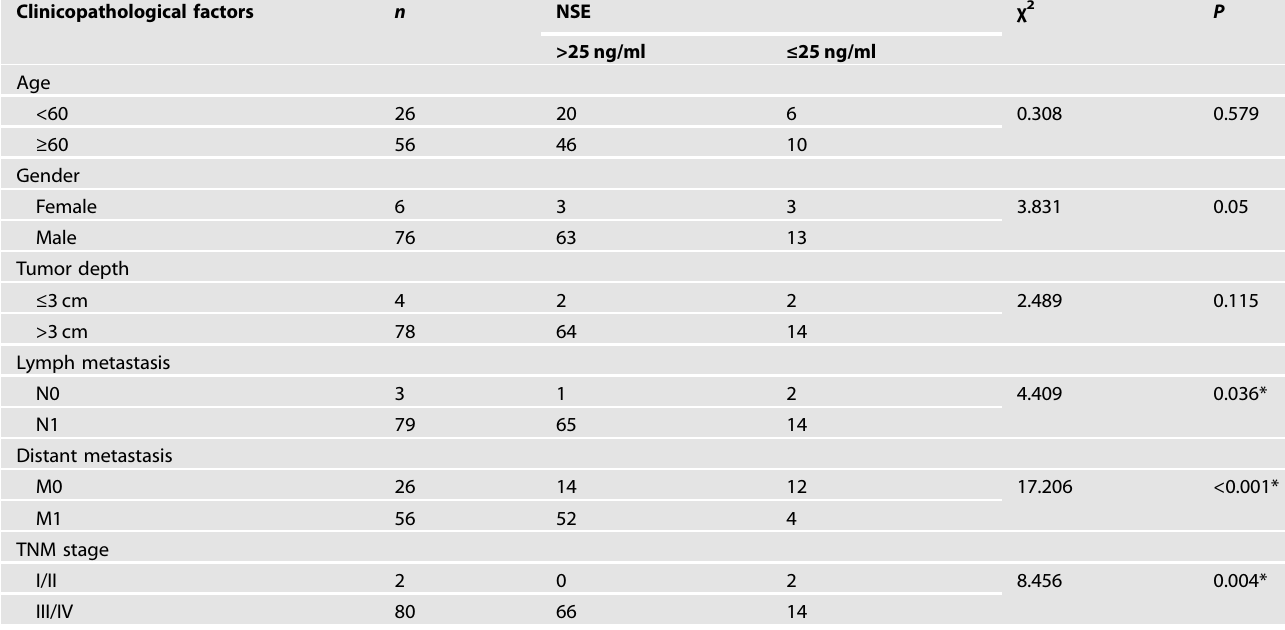
Table 1. The correlations between NSE serum concentrations and clinicopathological parameters of SCLC patients. Clinicopathological